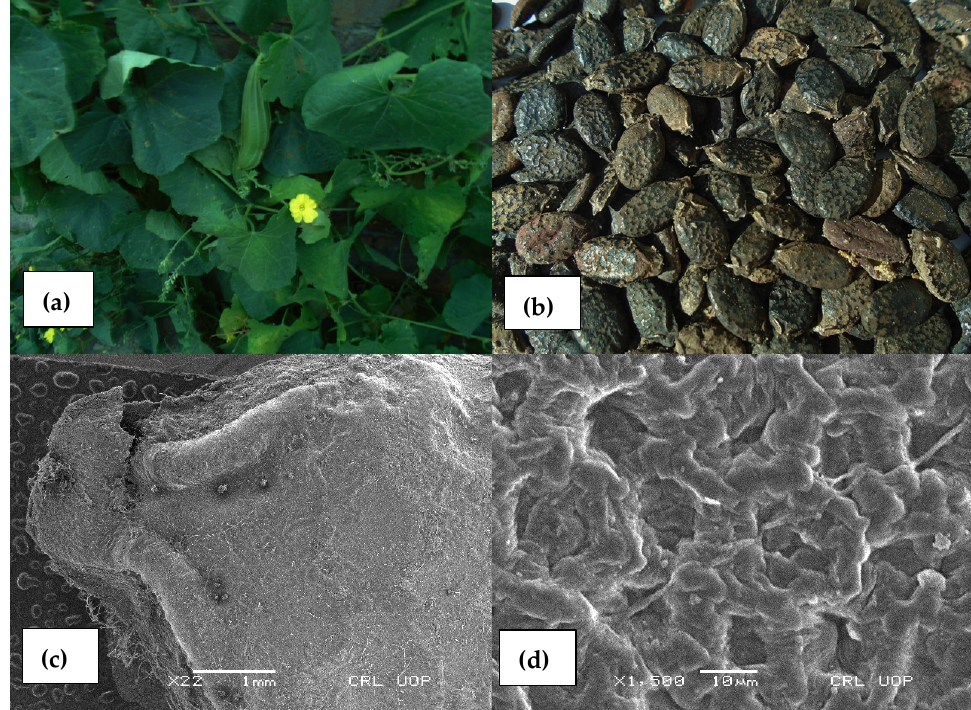
Figure 4. Luffa acutangula ( a ) plant, ( b ) s eeds, and ( c , d ) SEM micrograph of seed sculpturing.